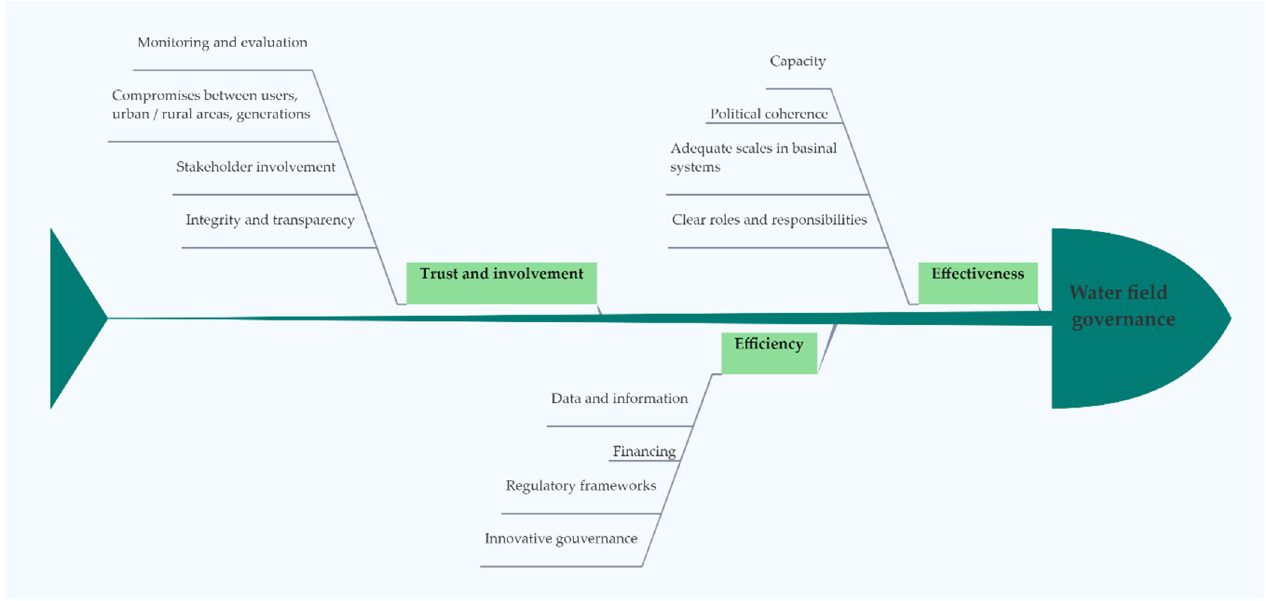
Figure 1. The OECD Principles on Water Governance [11] (Authors’ own source).